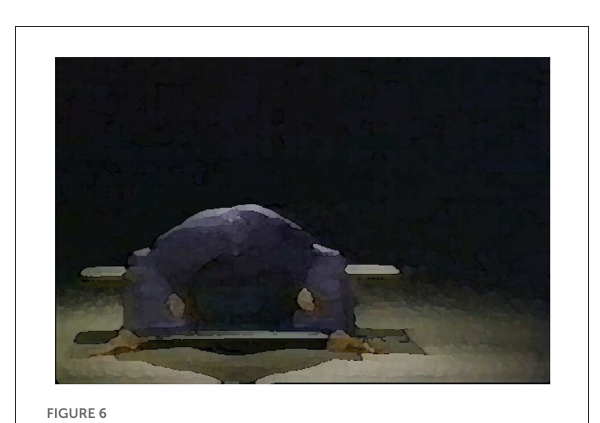
FIGURE6 The media frame of the arrival point of move